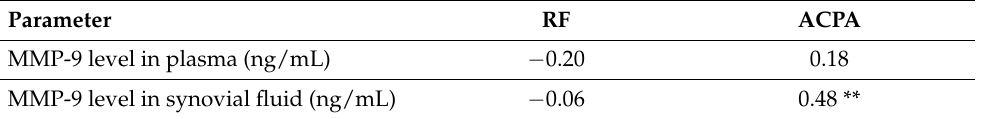
Table 5. Correlation of MMP 9 level in plasma and synovial fluid with serological parameters of RA. Parameter RF ACPA MMP-9 level in plasma (ng/mL) − 0.20 0.18 MMP-9 level in synovial fluid (ng/mL) − 0.06 0.48